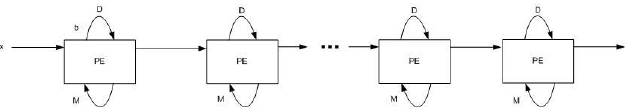
Fig. 11 Systolic array diagram block edge map